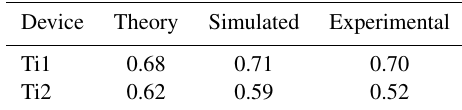
Table 7. A comparison of the average thermal coupling coefficient, β 12 , of the dual-element devices at atmospheric